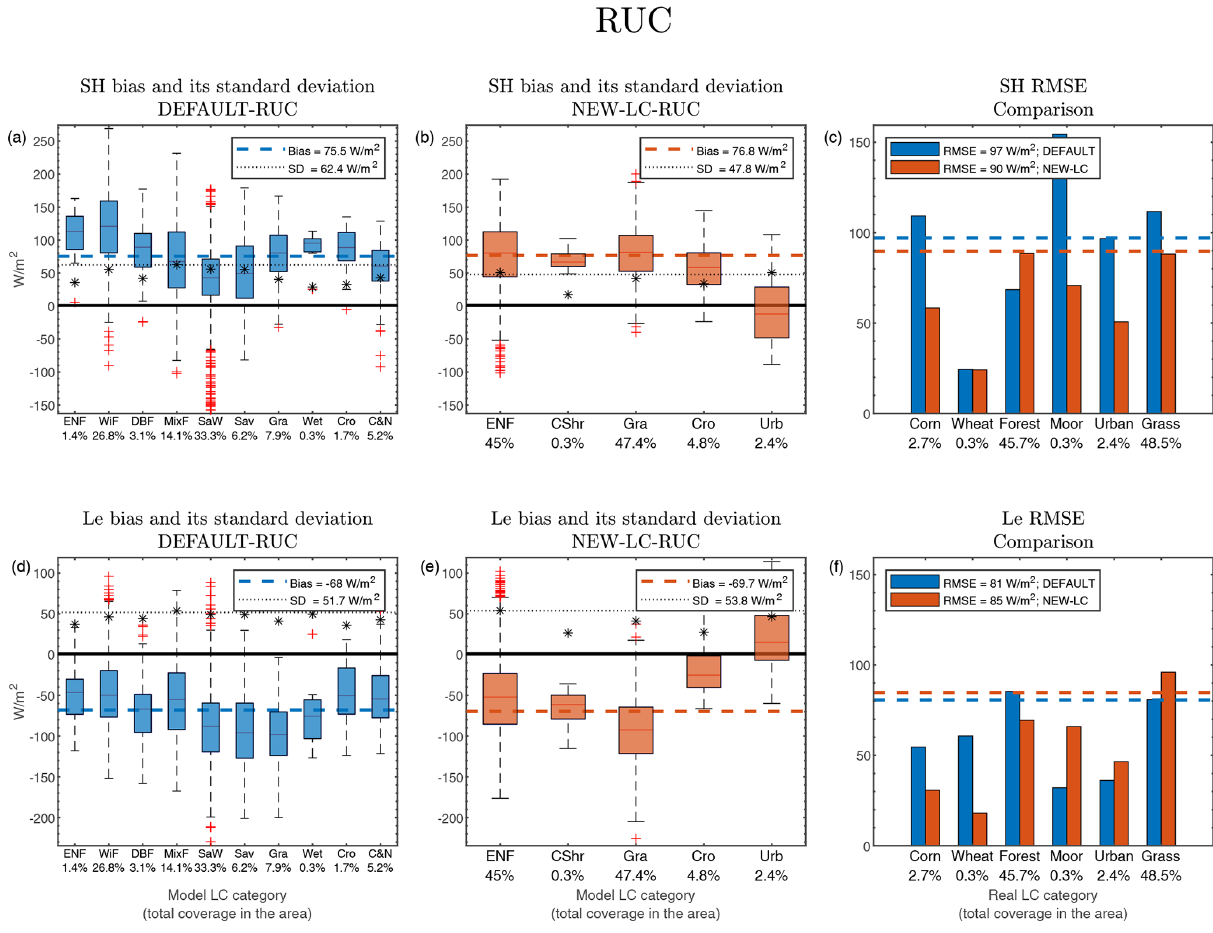
Figure 5. Same as in Fig. 3 but for